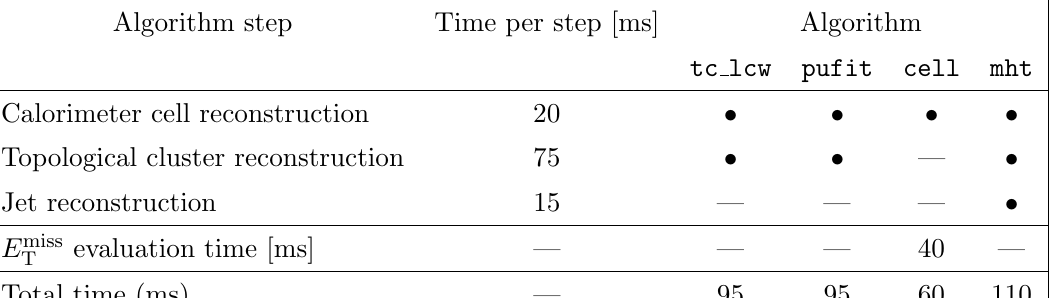
Table 3. The average execution time of each step in computing E miss